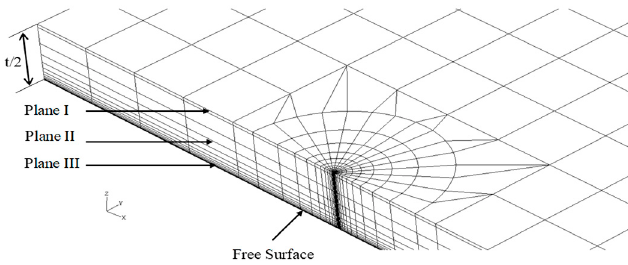
Figure 4. Finite element mesh for 3D SECP specimen (crack front).